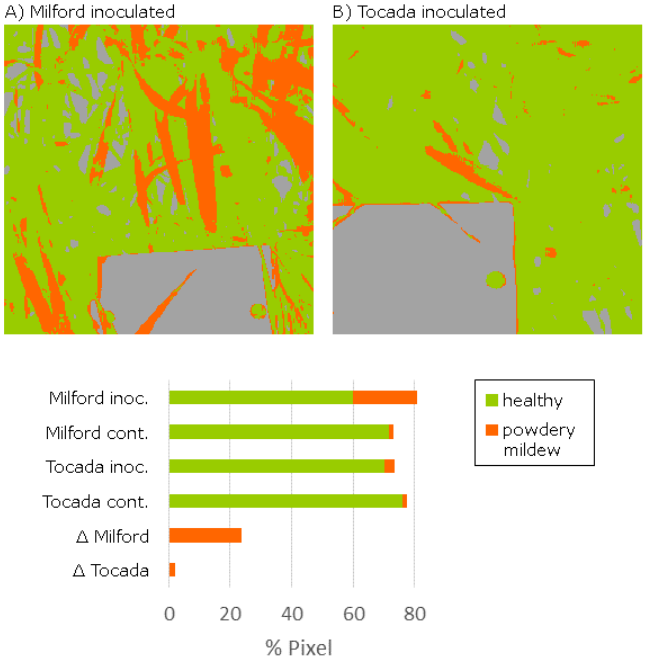
Figure 8. Evaluation for the images of inoculated barley plants by a Support Vector Machine classification model (green: healthy, orange: symptom, gray: background): Cultivar (cv.) Milford shows significantly more affected pixels whereas the cv. Tocada shows only a few symptoms in the measured part of the canopy. Percentage of affected pixels is given for inoculated (inoc.) and healthy control (cont.)